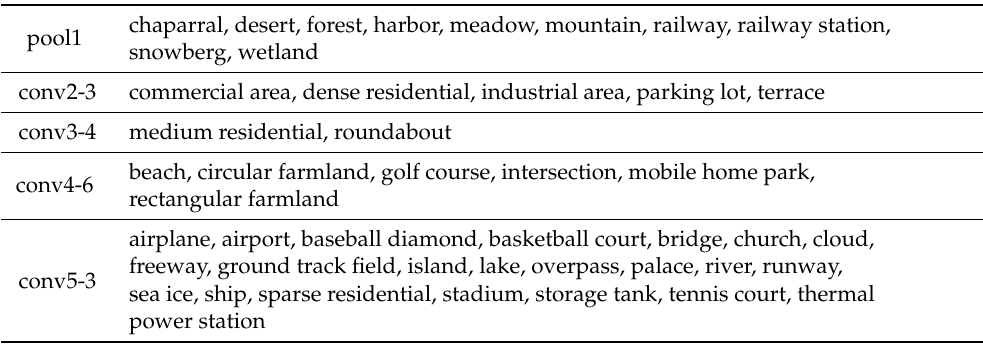
Table 6. The optimal explanation layer from ResNet-50 for each class of NWPU-RESIS45 dataset.